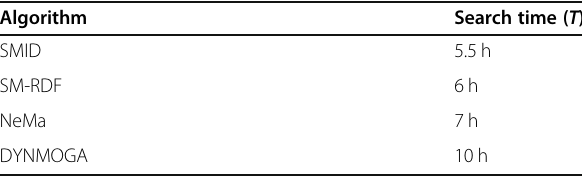
Table 2 The comparison of time efficiency